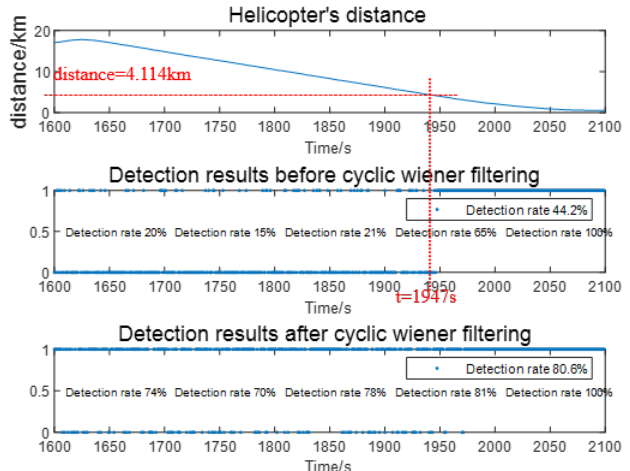
Figure 15. Helicopter long-distance detection results.